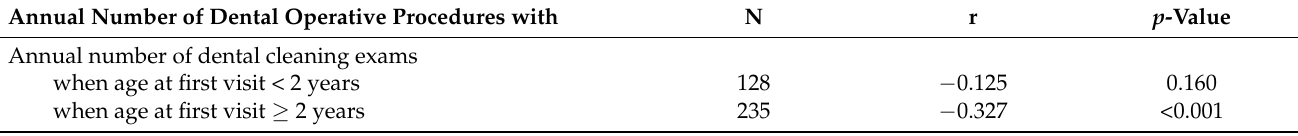
Table 3. Pearson correlation (r) between annual number of dental operative procedures and the annual number of dental cleaning exams across age groups.